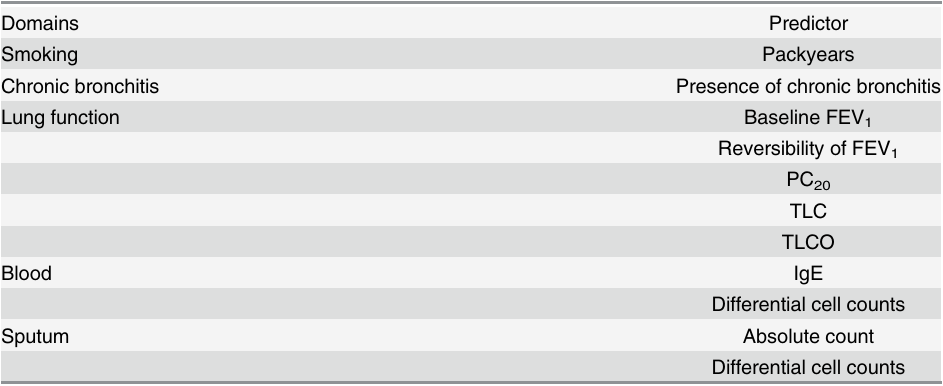
Table 1. A priori defined predictors. 5 Domains of potential predictors are listed in the table: (1) packyears; (2) presence of chronic bronchitis; (3) lung function (4) TLCO; and (5) absolute and differential cell counts in induced sputum.